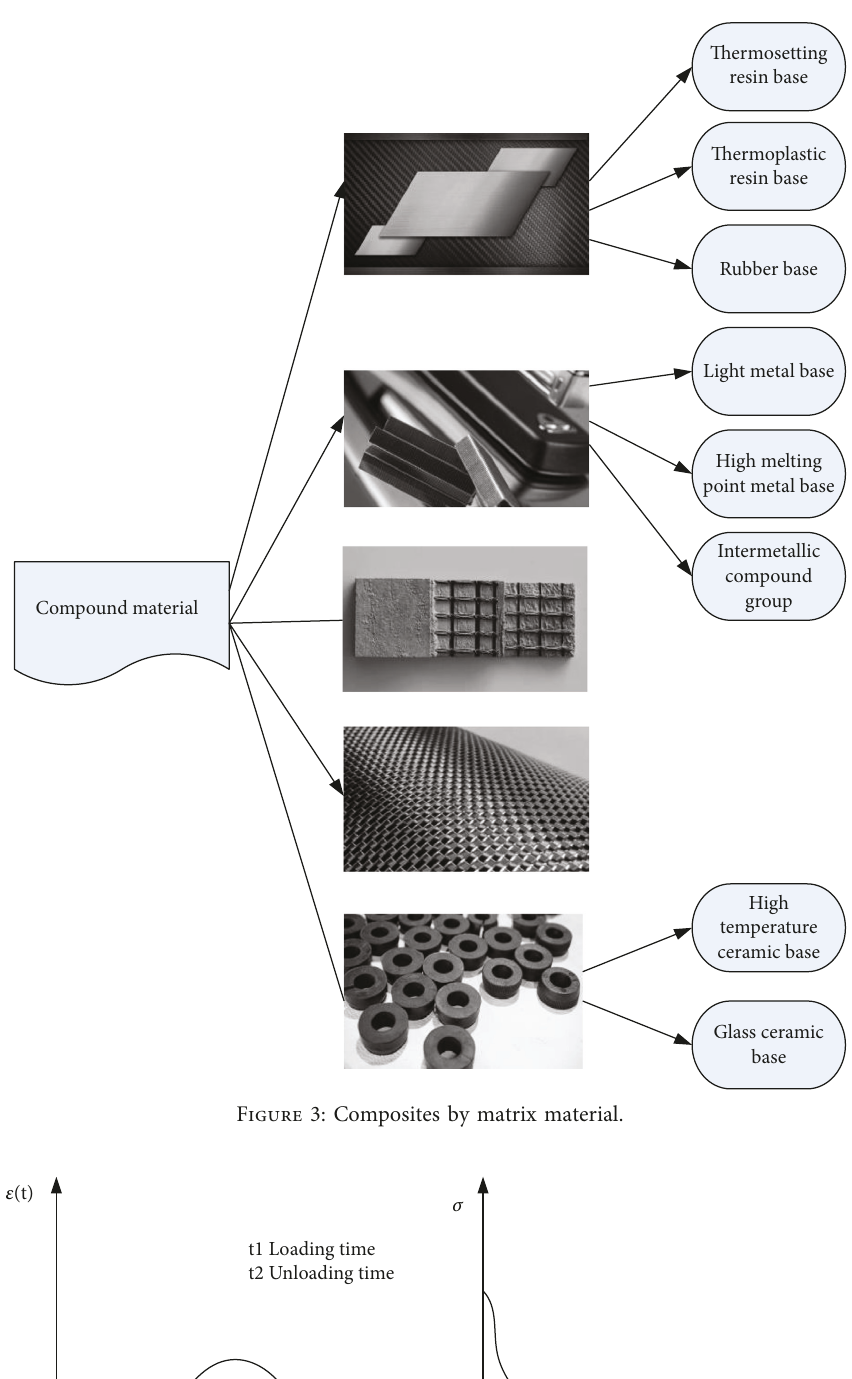
Figure 4: Creep and stress relaxation curves of